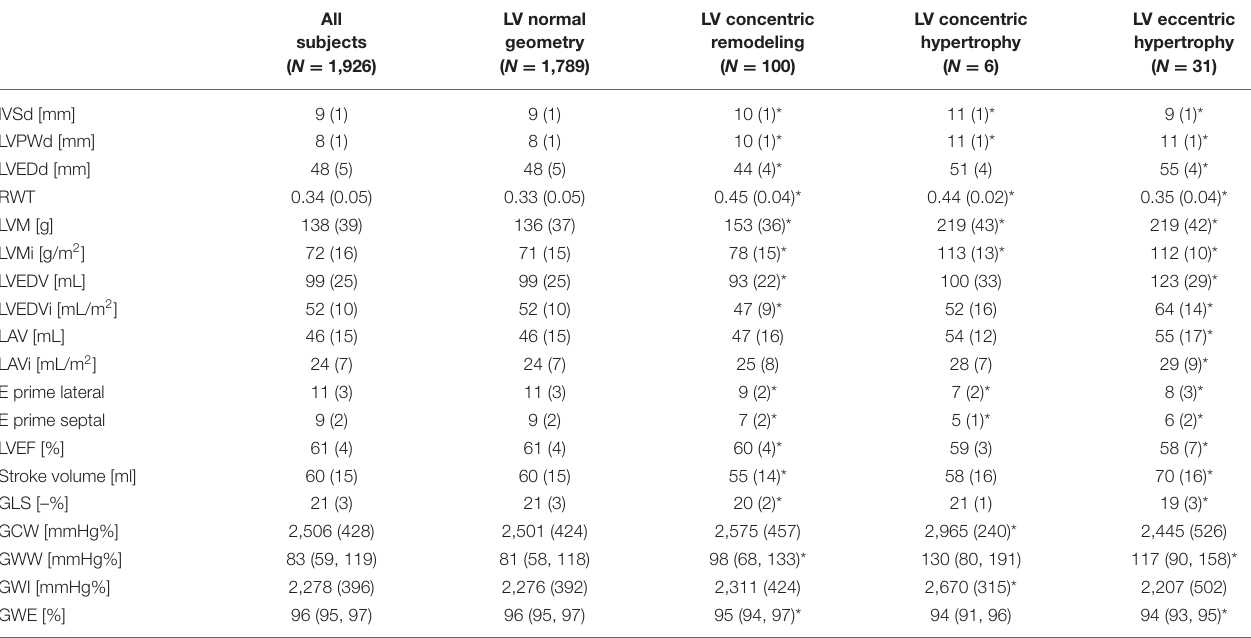
TABLE 2 | Baseline echocardiographic characteristics including myocardial work according to the LV geometry classification. All subjects